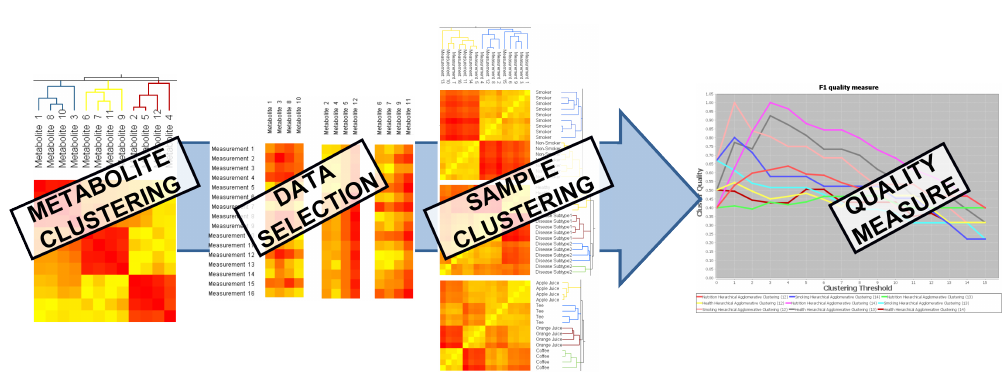
Figure 2. The subset selection allows for the analysis of the hidden structures in the data. Steps 2–4 from Figure 1 are repeated on a selected subset (or all